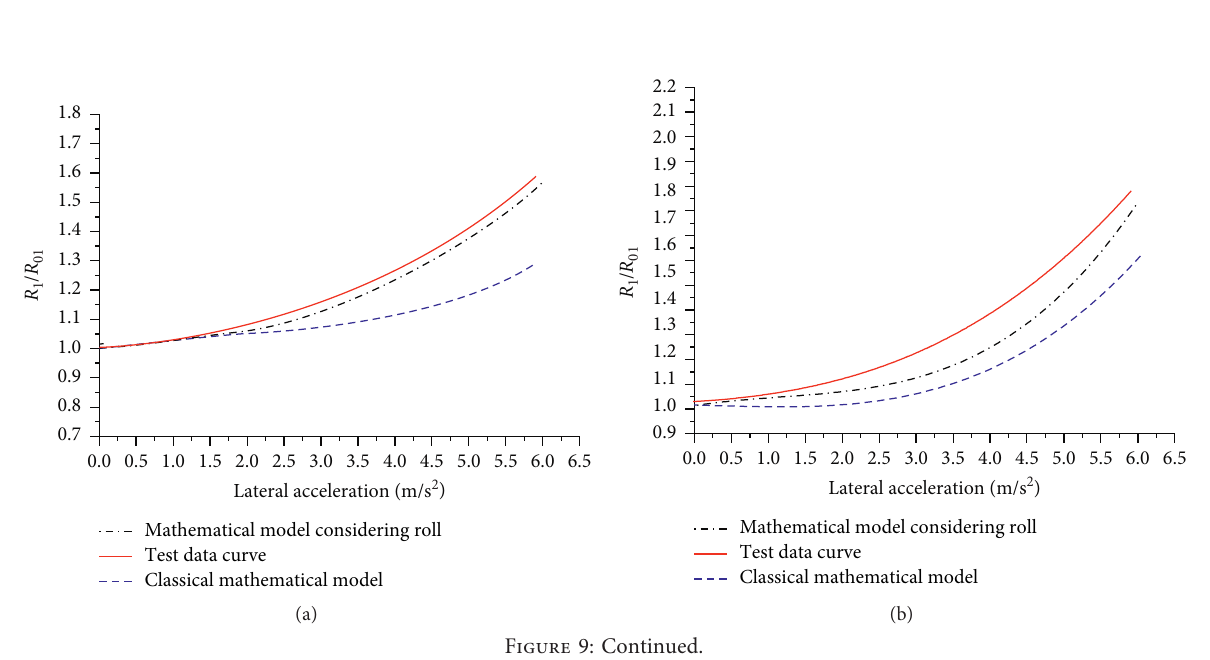
Figure 8: Semitrailer I test curve and the ratio of cornering radius.